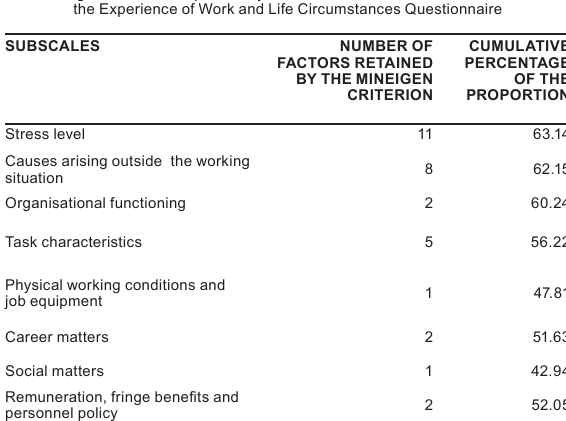
table 2 Percentage of variance explained by the factors extracted from the subscales of the Experience of Work and Life Circumstances